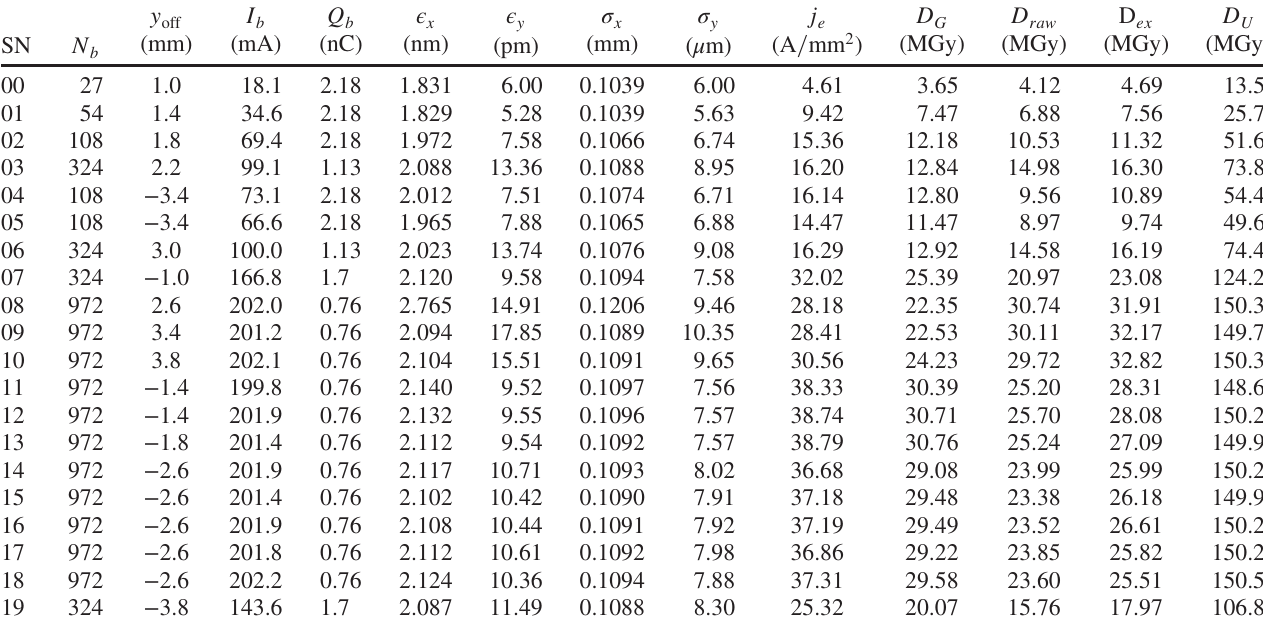
TABLE VI. Chronological sequence number (SN), number of bunches N b , y offset, beam current, I b , charge per bunch, Q b , emittance, spot sizes σ x;y , current density j e , peak Gaussian profile dose D G , peak raw dose D MARS from the January 2020 experiment, D ex and dose scaled to APS-U conditions, D U . The target material in both test pieces is Al-T6061. N